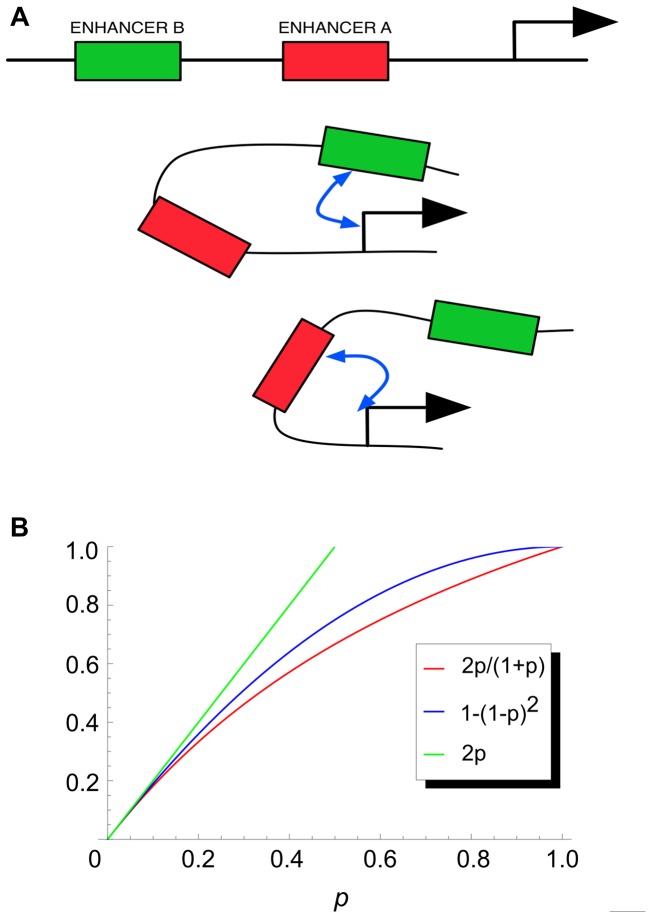
(A) A gene locus with two enhancers (A and B) can be in one of three different configurations of enhancer-promoter interaction: (top) neither enhancer interacts with promoter, (middle) only B interacts and (bottom) only A interacts.In a configuration where A interacts with promoter, B does not interact, and vice versa. (B) Combining contributions from two enhancers. If each enhancer's contribution is given by the gene expression probability p due to that enhancer, the combined contribution of the two enhancers (assuming independent interactions with the promoter) is 2p/(1+p), plotted in red. For small values of p, this is well approximated by 2p (green), the sum of their contributions. For larger values of p, a better approximation is provided by the function 1−(1−p)2, in blue.